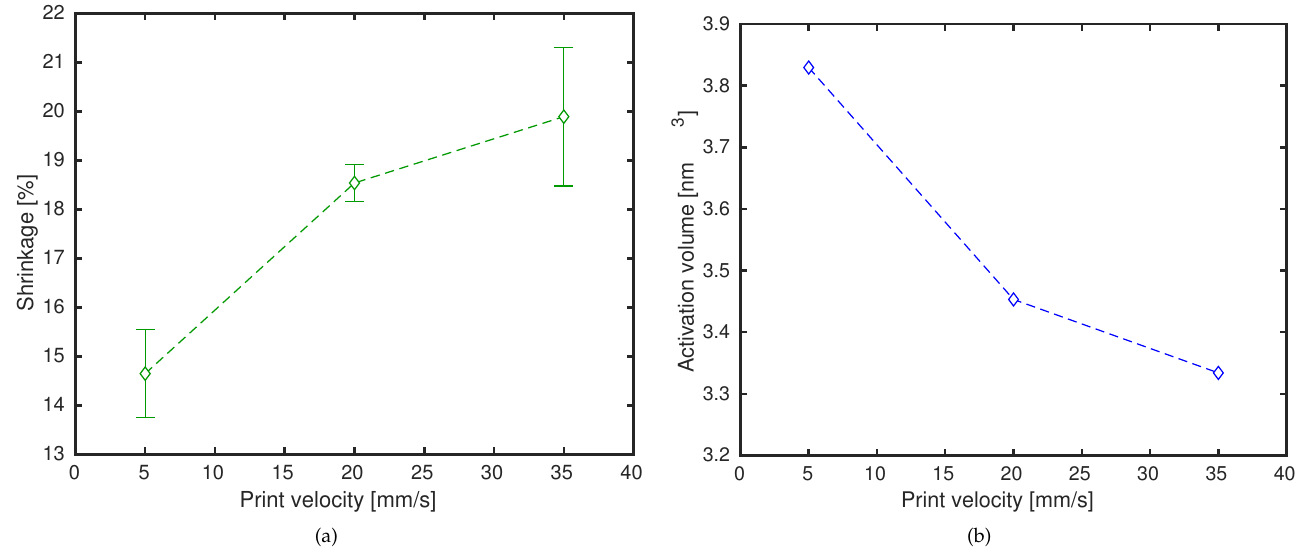
Figure 5. ( a ) dimensional length changes as a function of print velocity. Symbols are experimental results. Lines are a guide to the eye; ( b ) determined activation volume as a function of print velocity. Lines are a guide to the eye.